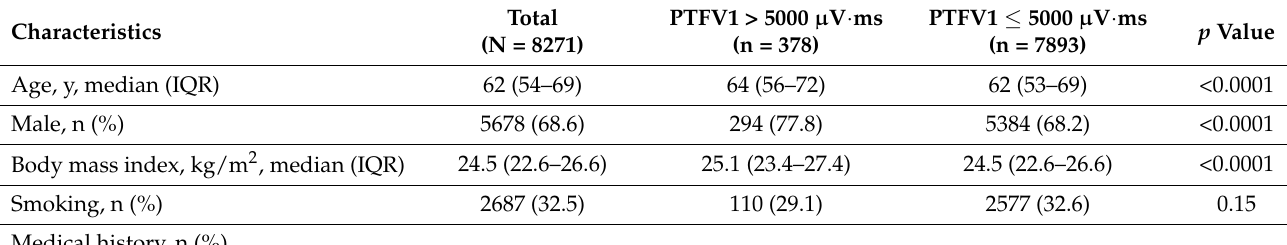
Table 1. Baseline characteristics of the study population classified by